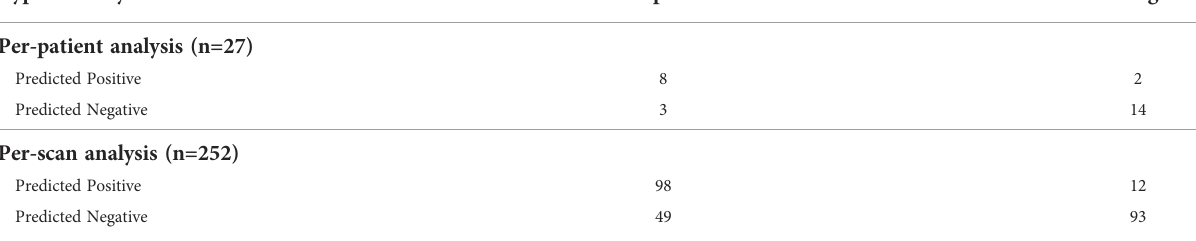
TABLE 3 Confusion matrix for margin